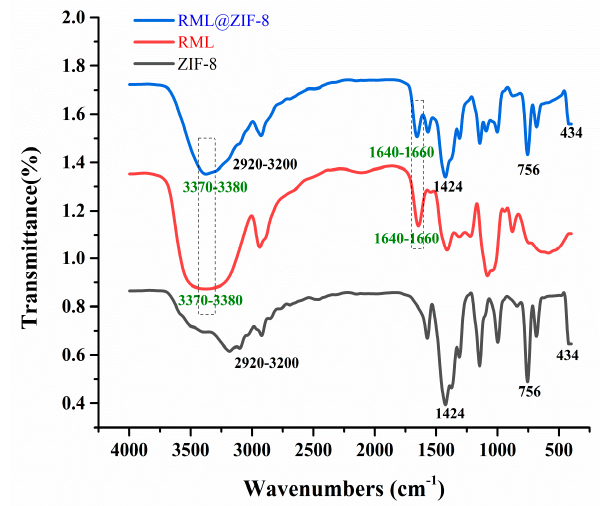
Figure 3. Fourier transform infrared (FT ‐ IR) spectra of samples of ZIF ‐ 8, RML, and ZIF ‐ 8@RML.